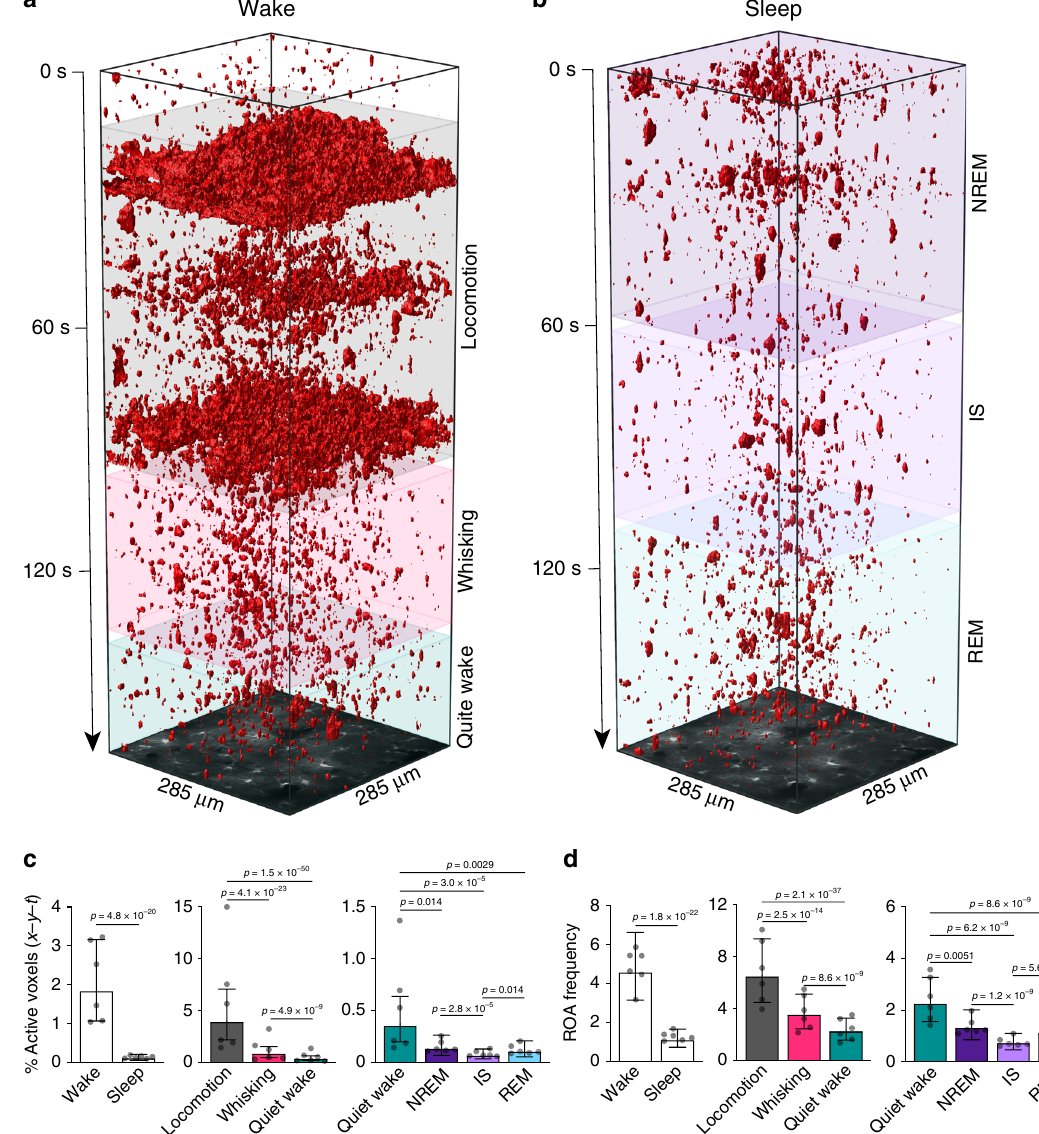
Fig. 2 Astrocytic Ca 2 + signaling is reduced during sleep and is sleep state speci fi c. a and b Representative x-y-t rendering of ROAs during wakefulness ( a ) and sleep ( b ). c Percentage of active voxels ( x-y-t ) during overall wakefulness and overall sleep (left), during locomotion, whisking and quiet wakefulness (middle), and during NREM, IS, and REM sleep as compared to quiet wakefulness (right). d Same as c but for ROA frequency expressed as number of ROAs per 100 μ m 2 per minute. Data represented as estimates ± SE and p -values (two-sided test, no adjustment for multiple comparisons) derived from linear mixed effects models statistics, n = 6 mice, 283 trials. For details on statistical analyses, see “ Methods. ” See also Supplementary Figs. 8 – astrocytic somata ROIs across all sleep-wake states (Fig. 3b). Still, both astrocytic somata and processes displayed similar magnitude and direction of change in Ca 2 + signaling across sleep-wake states (Fig. 3b and Supplementary Fig. 11). To conclude, astro- cytic Ca 2 + signals are more frequent in processes than somata not only during wakefulness, but also during sleep.